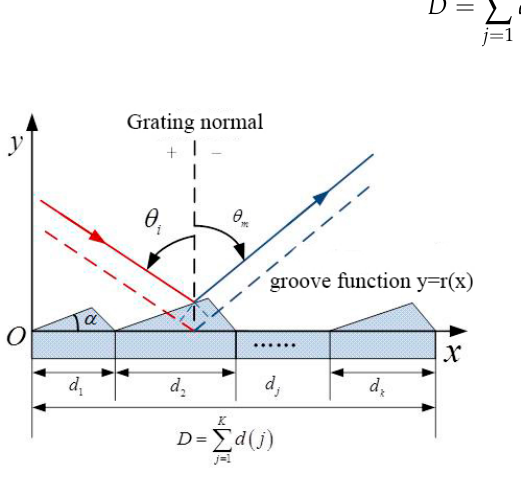
Figure 4. Schematic diagram of the ghost line groove error model.